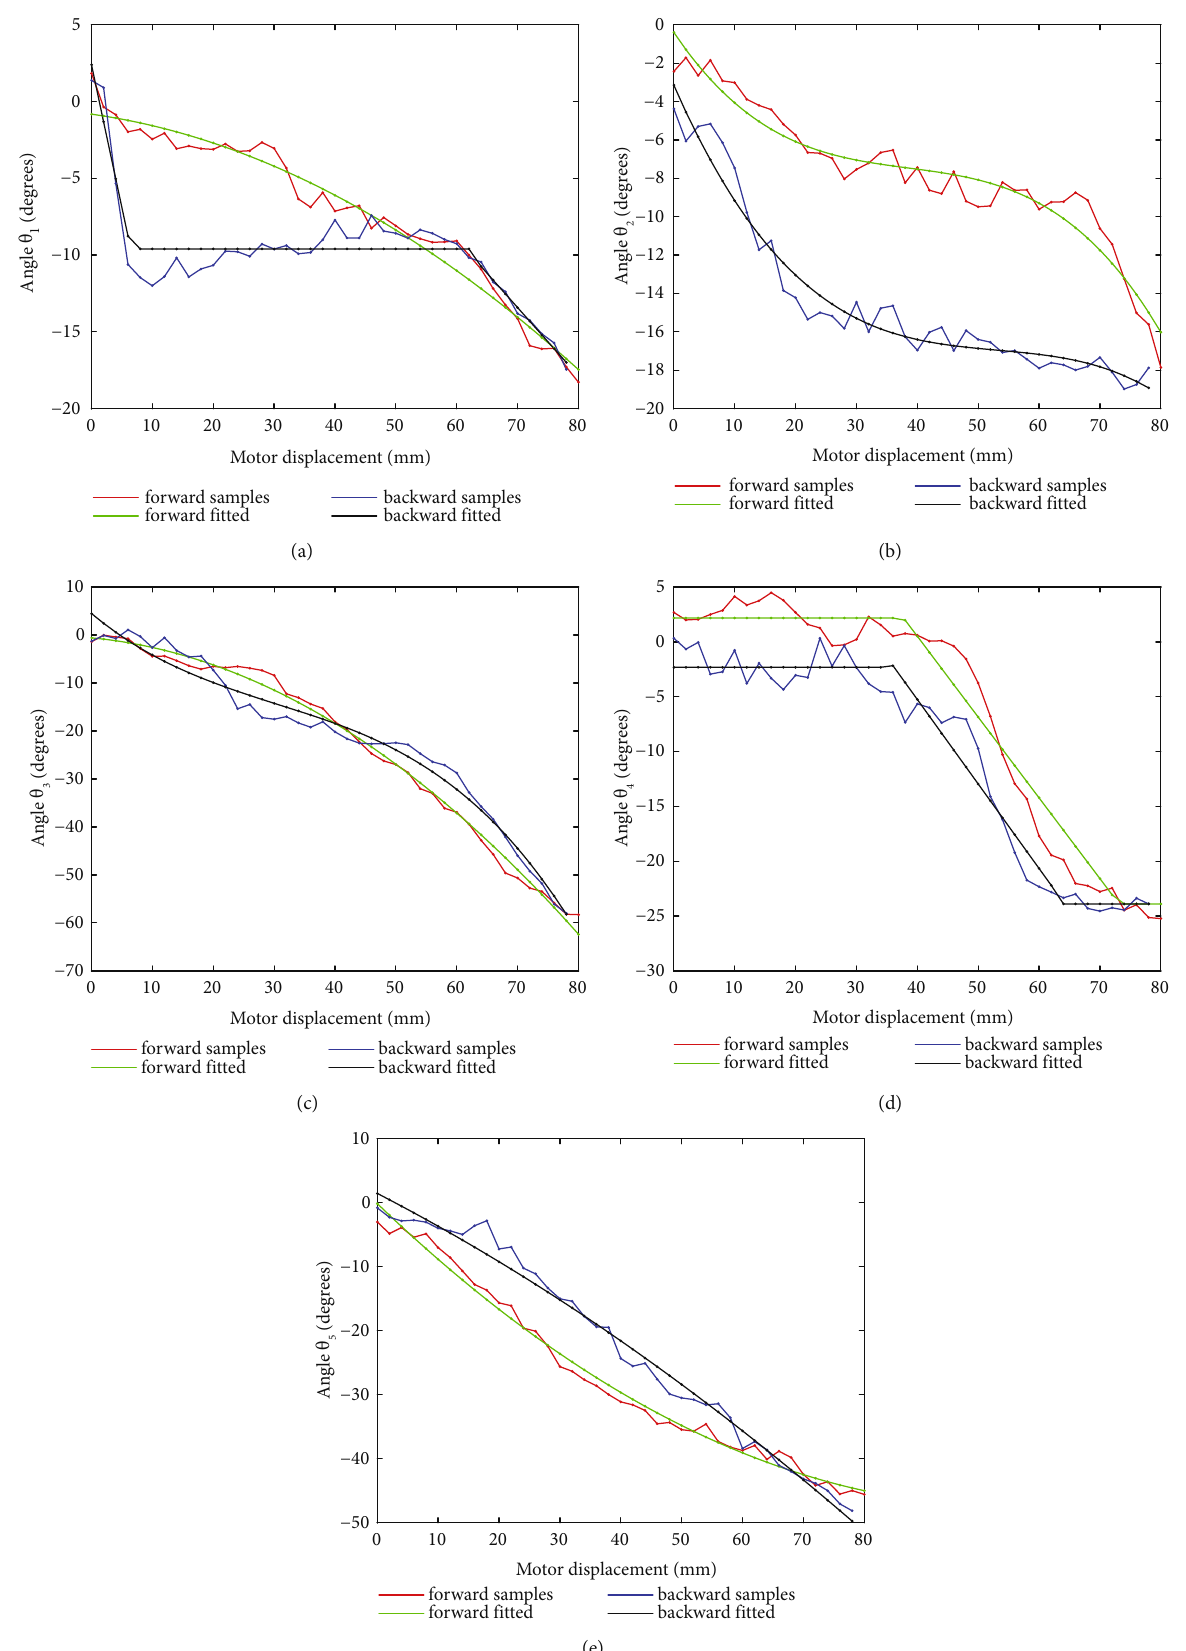
Figure 10: Angular displacements θ i measured in both forward and backward